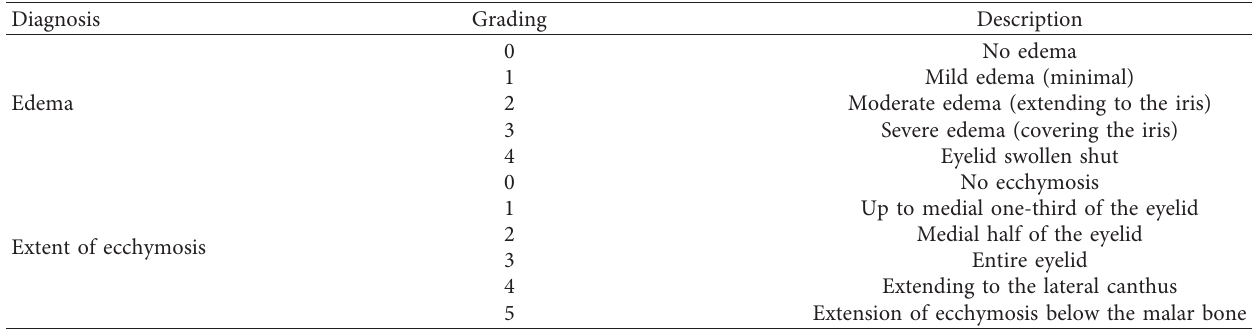
Table 1: Description of grades used for the assessment.